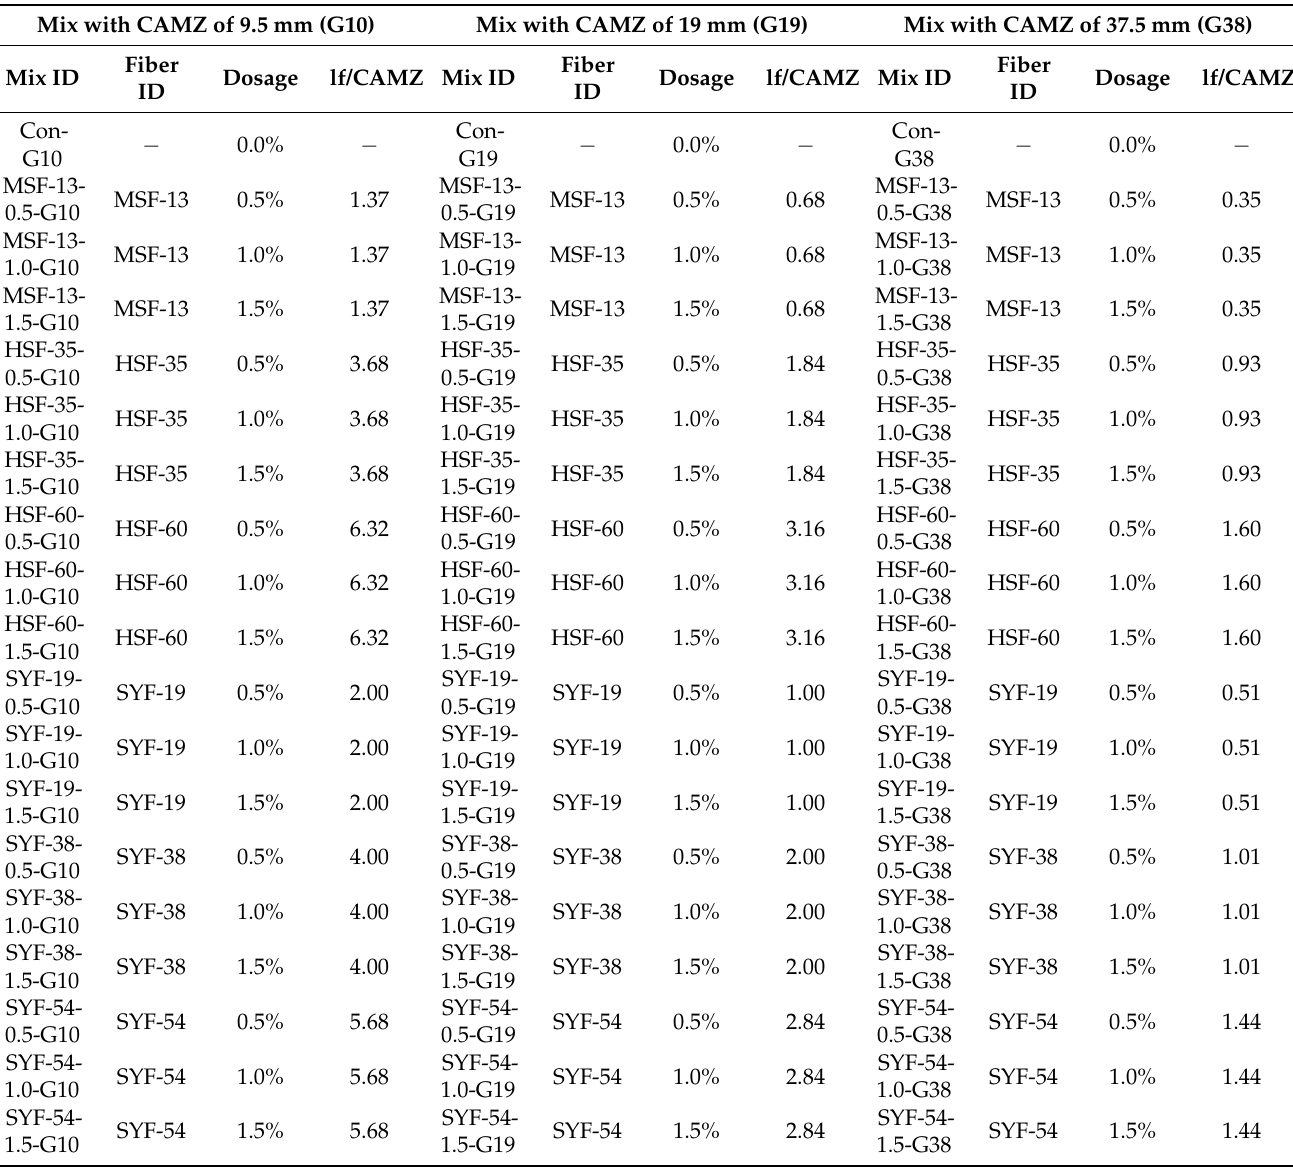
Table 7. Fiber-reinforced concrete (FRC)